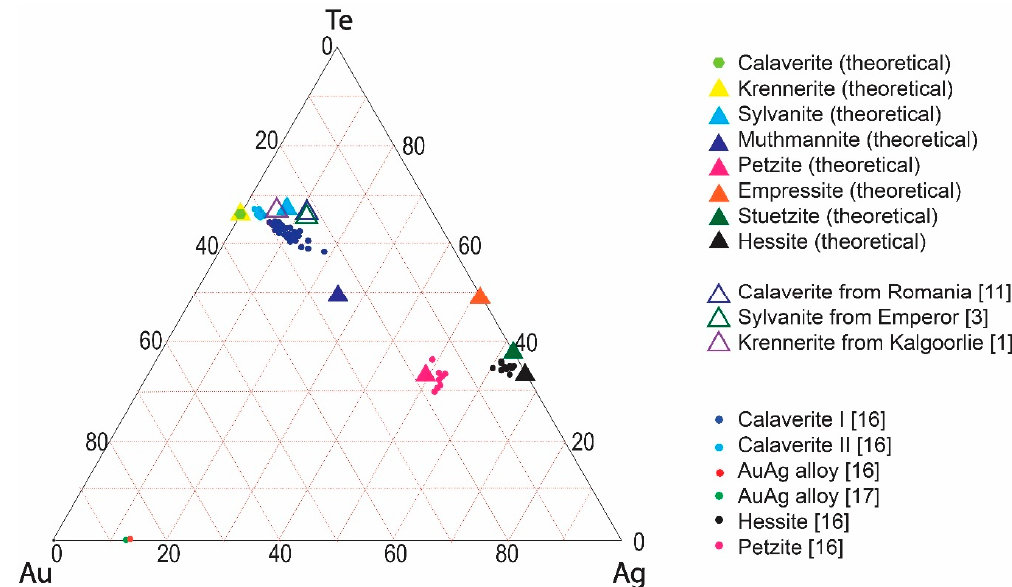
Figure 1. Ternary diagrams of Au–(Ag)–Te system (atom%), showing compositions of gold–(silver) tellurides from mineral database [15] and references [1,3,8,11,16,17]. Compositions of synthetic gold–(silver) tellurides [16,17] are shown as small colored dots.